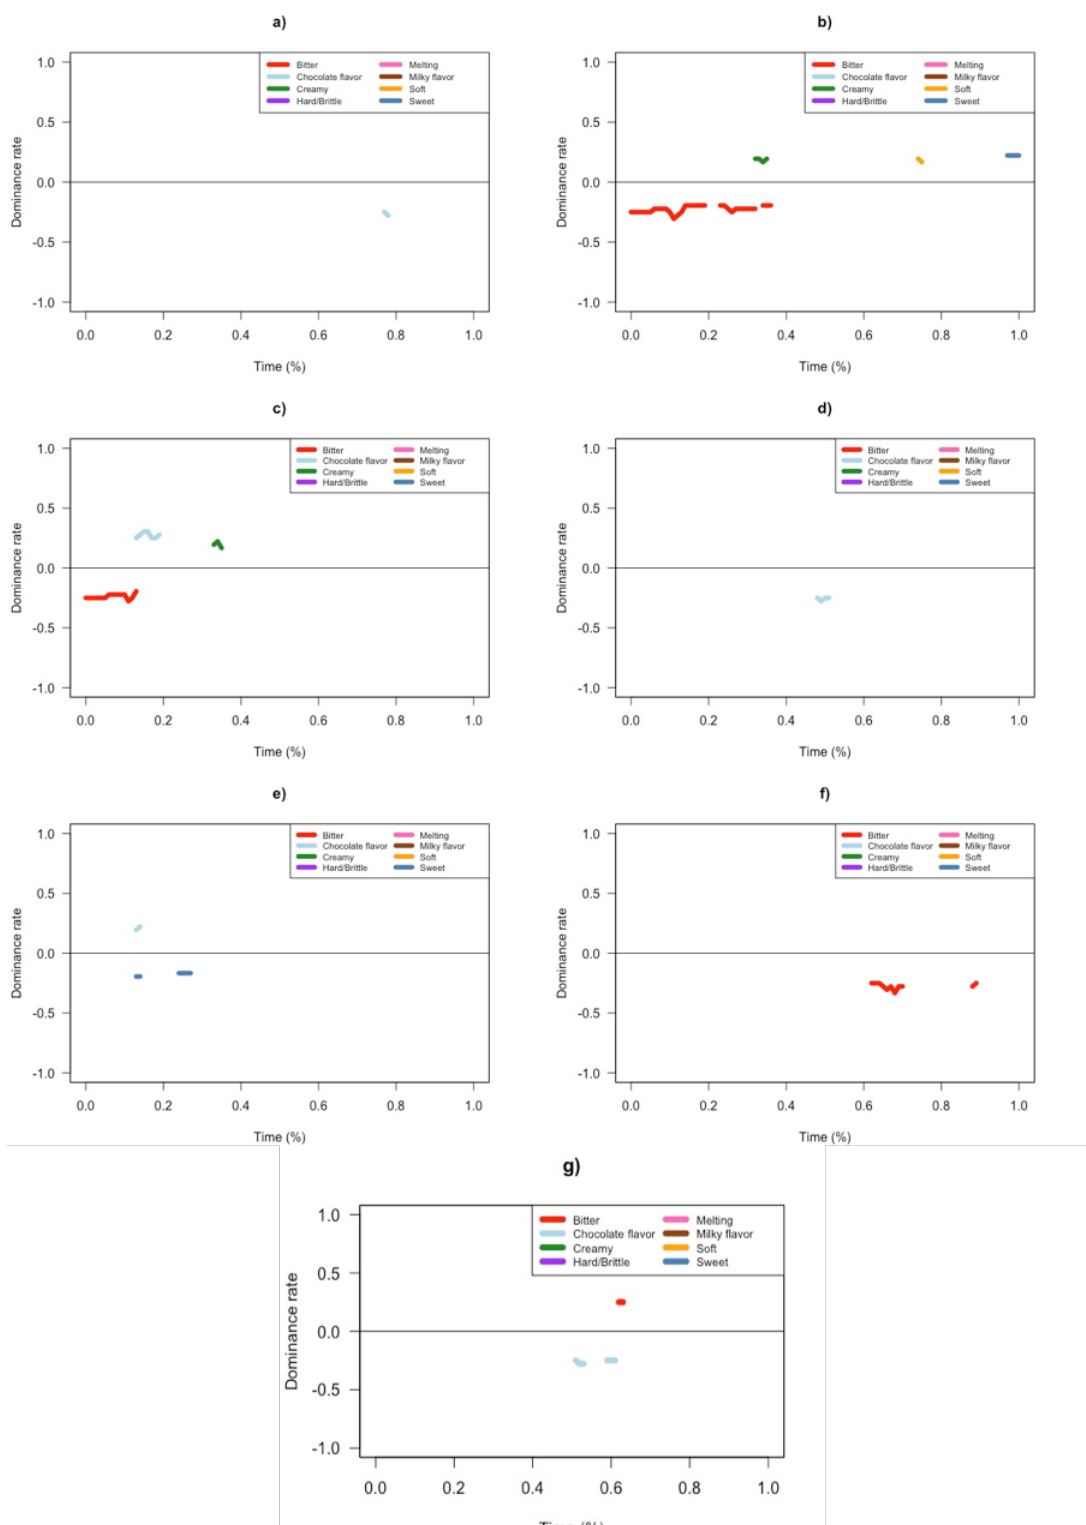
Figure 2. Temporal Dominance of Sensation (TDS) difference curves comparing samples with similar overall sweetness: ( a ) HHH-HLH; ( b ) HHH-HHL; ( c ) HLH-HHL; ( d ) HLH-LHL; ( e ) LHL-HHL; ( f ) LHL-LLL; ( g ) LLL-HLL. For almost all of the samples with similar overall sweetness, differences were ob- served in the dominance rates for sweet, bitter, chocolate flavor, creamy and soft. The